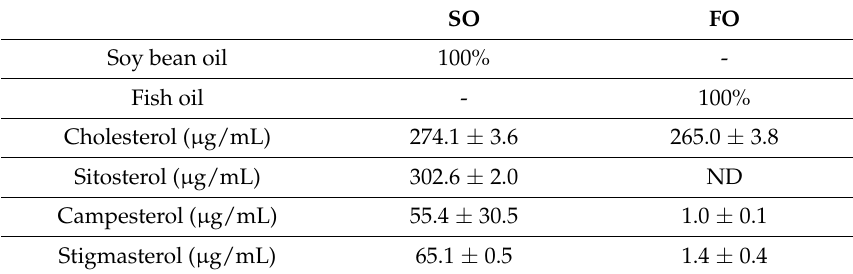
Table 1. Composition of the soy-based lipid emulsion and the fish-based lipid emulsion. SO FO Soy bean oil 100%